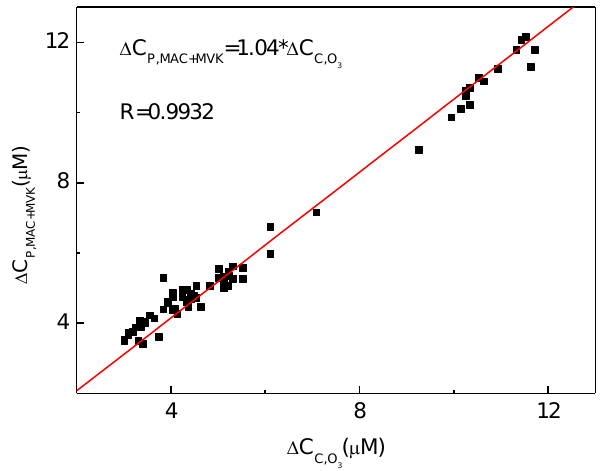
Fig. 2. The linear regression of the proportion of the formed product concentration (C P,MAC+MVK ) versus the consumed ozone concen- ). n = 72. tartion ( 1 C C,O 3